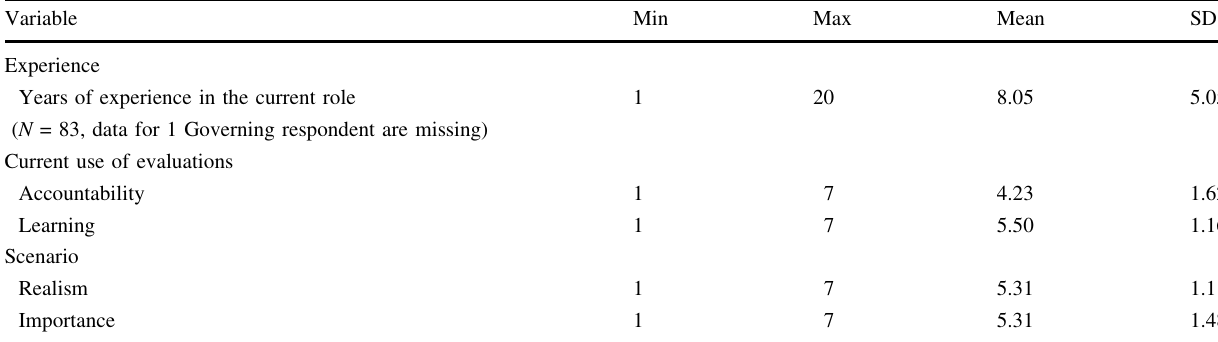
Table 4 Respondent-level descriptive statistics ( N =